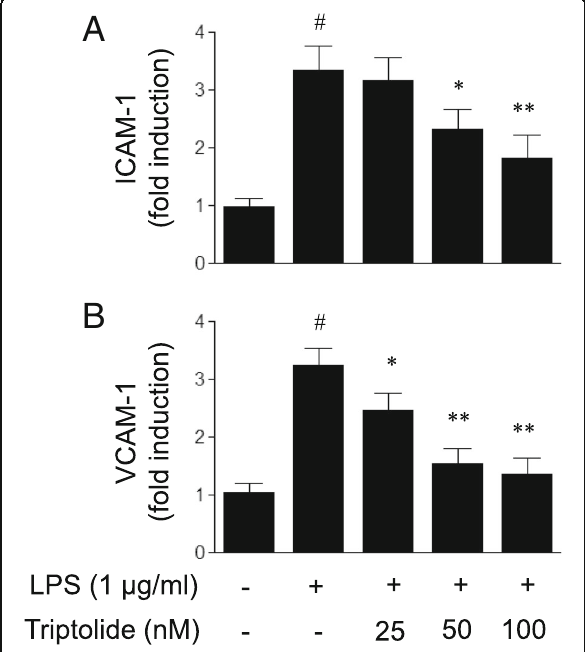
Fig. 3 The effects of triptolide on lipopolysaccharide (LPS)-induced ( a ) ICAM-1 and ( b ) VCAM-1 expression in human umbilical vein endothelial cells (HUVECs). HUVECs were treated with LPS (1 μ g/ml) in the presence or absence of triptolide (25, 50 or 100 nM) for 6 h. The cell-based ELISA assay was used to quantify the expression of ICAM-1 and VCAM-1 in HUVECs. Data are expressed as the mean ± standard error of the mean. * p < 0.05 and ** p < 0.01, compared with LPS treatment alone. # p < 0.05, compared with the control